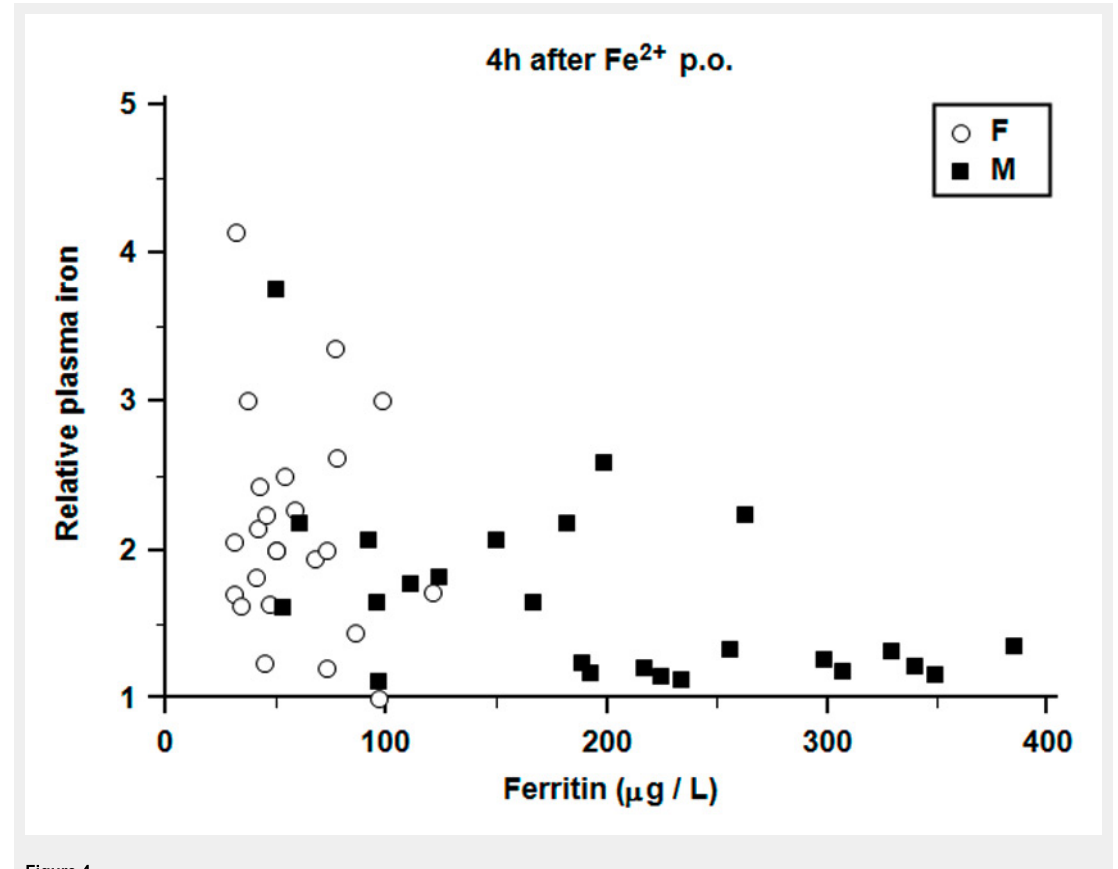
Figure 4 Correlation of initial ferritin and relative plasma iron concentration. Lower initial ferritin is correlated with a greater relative plasma iron increase. In general, females show lower ferritin values compared to